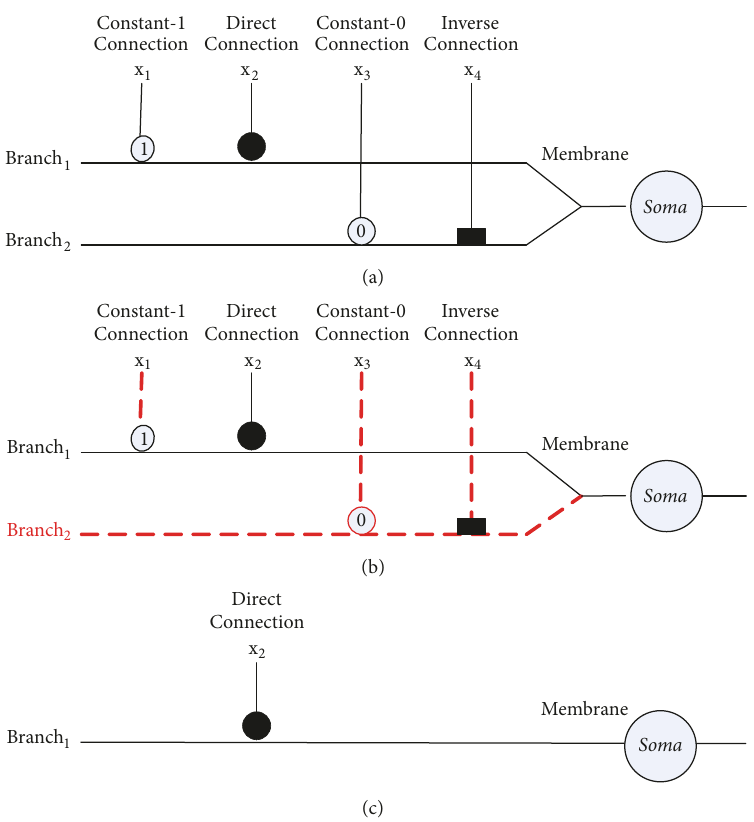
Figure 3: An example of a synaptic and dendritic pruning